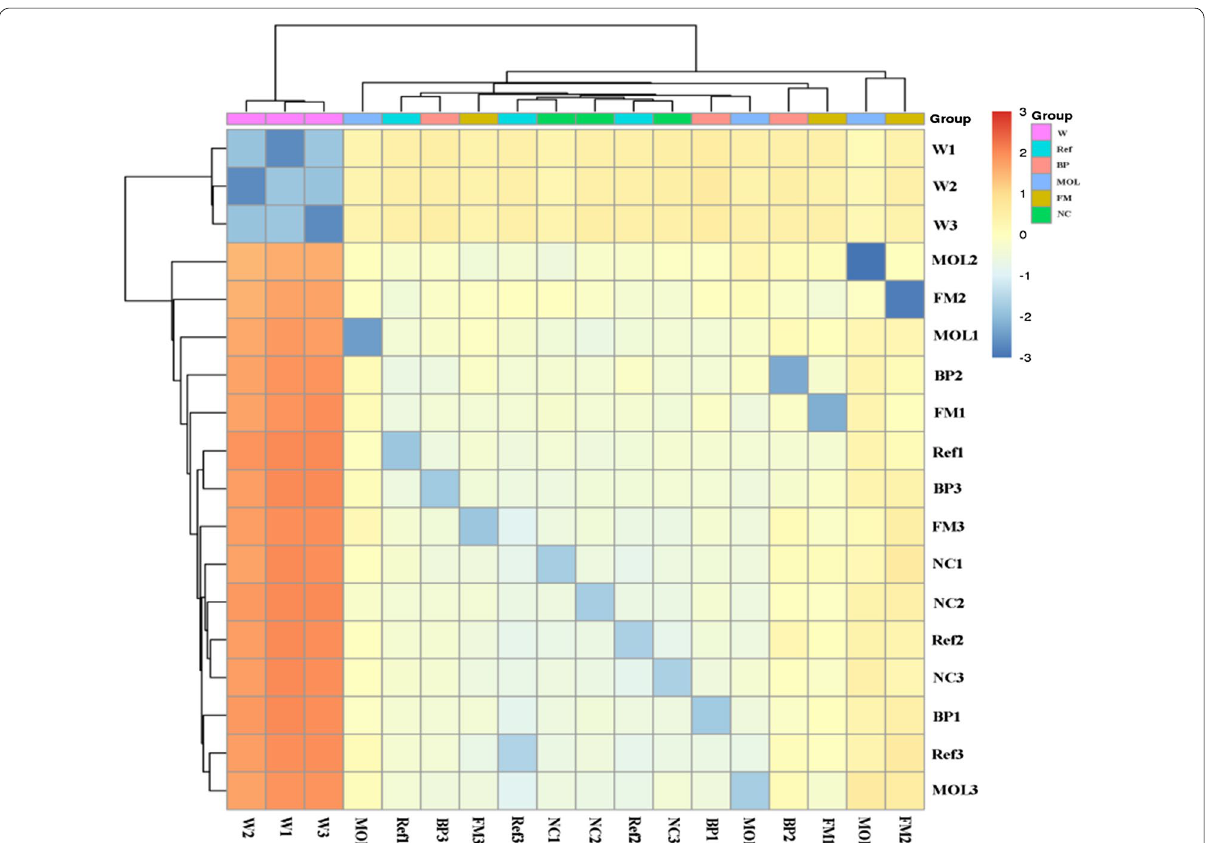
Fig. 5 The heatmap of all samples. The different color intensities represented the relative bacteria abundance in W, Ref, BP, NC, MOL and FM groups. Figure was constructed using binary Jaccard distances. The distance of samples gradually increased with the color from blue to